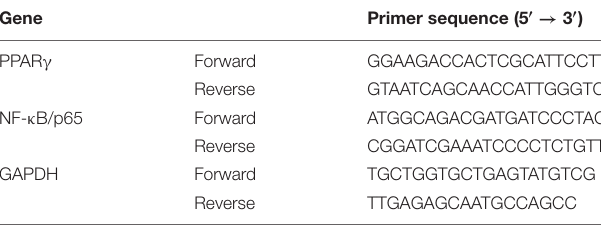
TABLE 1 | The primers used for real-time PCR. Gene